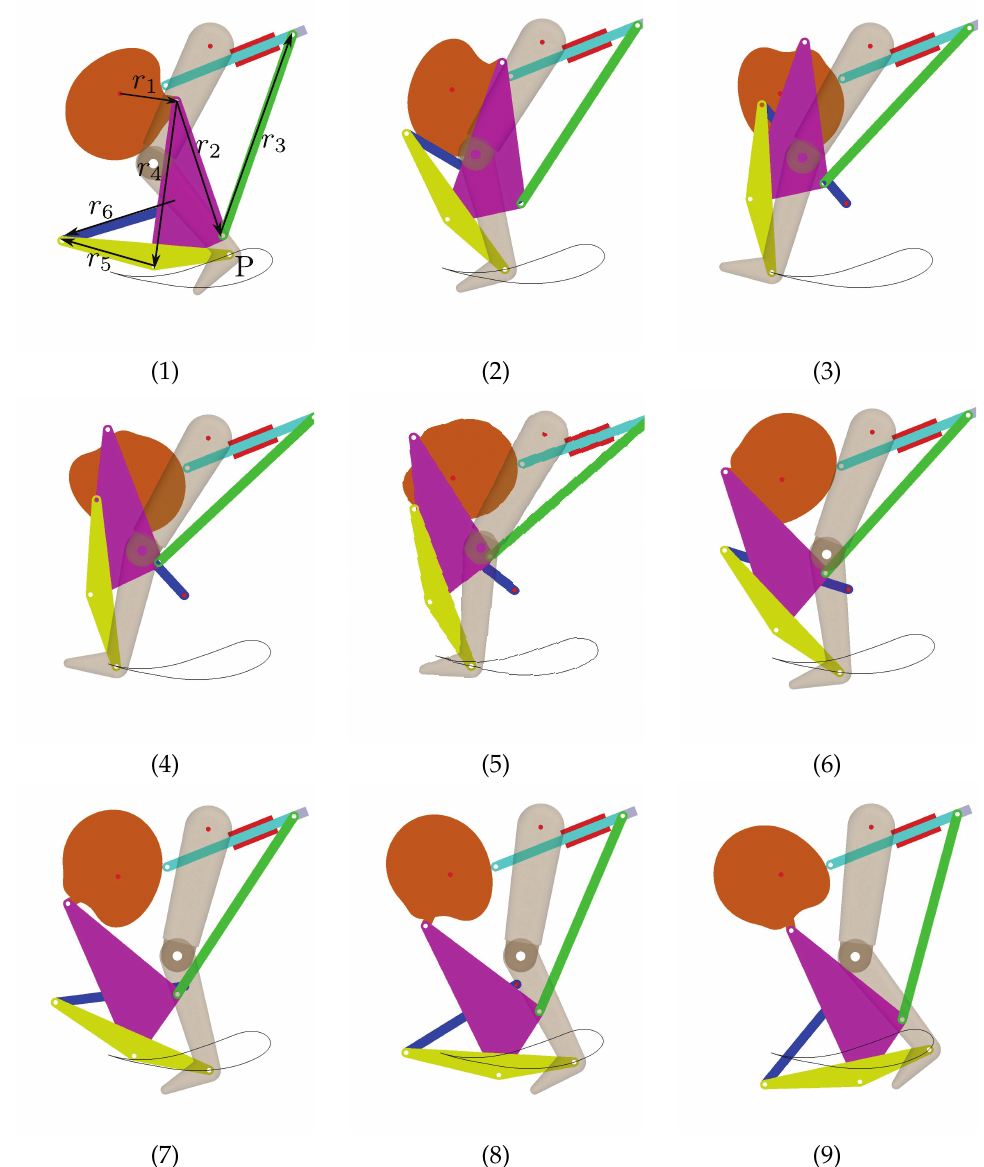
Figure 10. CAD representation of the best mechanism movement obtained by R1B-NCH for study case